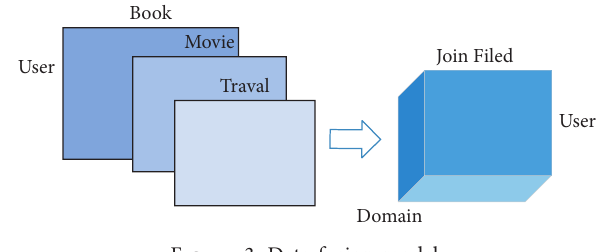
Figure 3: Data fusion model.